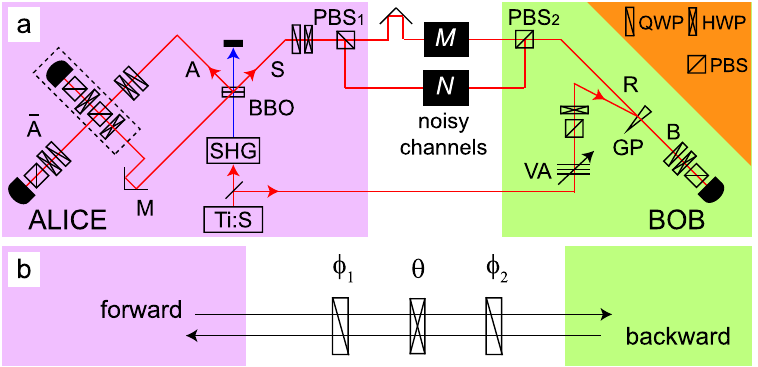
Figure 2. ( a ) Our experimental setup. The component surrounded by a broken line is the quantum parity check and projection onto |D 〉 for extracting and decoding the DFS. QWPs, HWPs and PBSs installed into paths A and B are for the quantum state tomography of the distributed states. Additional QWPs and HWPs in paths A and S at Alice’s side are for the quantum state tomography of the initial photon pair. ( b ) The reciprocal noisy channel denoted by M or N in Fig. 2(a). The operation is Q ( φ 2 ) H ( θ ) Q ( φ 1 ) for the forward-propagating photons, and is Q ( − φ 1 ) H ( − θ ) Q ( − φ 2 ) for the backward-propagating